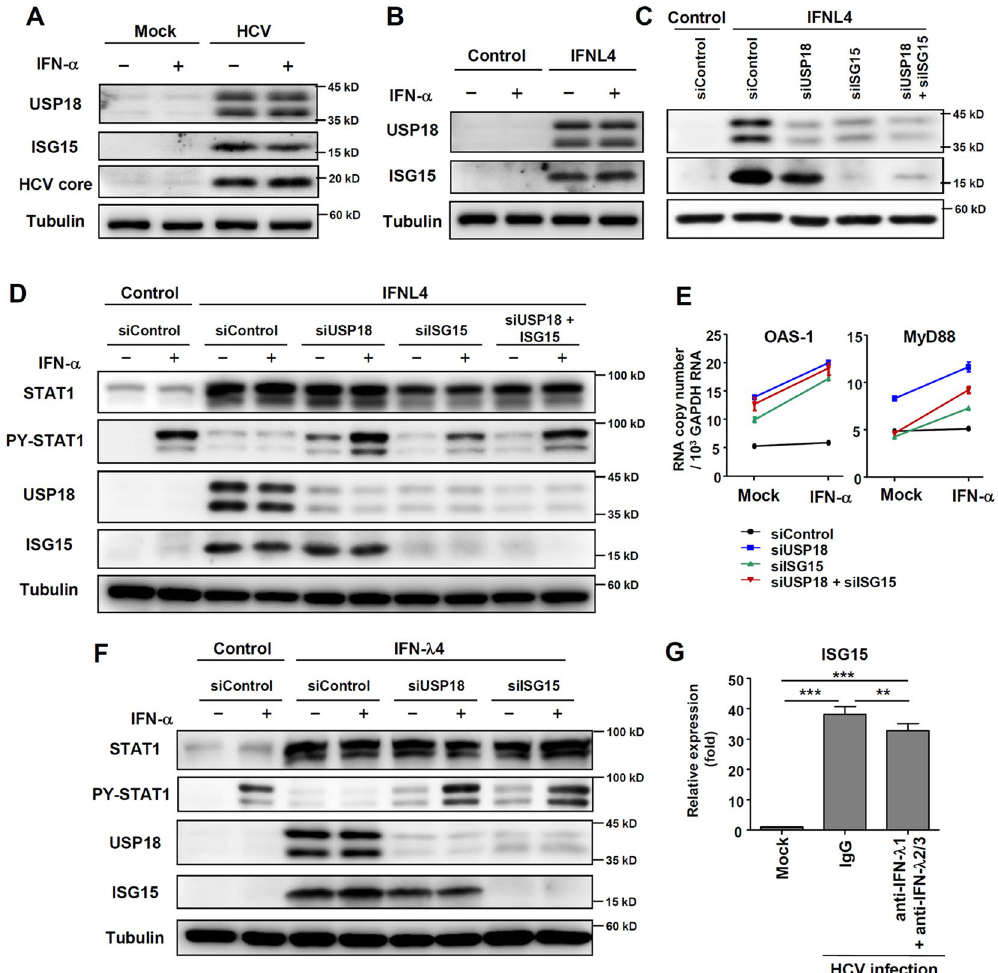
Figure 5. IFN- α unresponsiveness depends on ISG15 and USP18 in cells that overexpress IFN- λ 4 or treated with IFN- λ 4. ( A ) PHHs with the IFNL4 Δ G/ Δ G genotype were infected with JFH1 HCVcc at 5 MOI. After 72 hours, the cells were treated with 100 IU/ml of IFN- α for 30 minutes. ( B ) Huh-7 cells were transfected with control or IFN- λ 4-expressing plasmids. After 72 hours, the cells were treated with 100 IU IFN- α for 15 minutes. The cells were harvested, and protein expression was analysed by immunoblotting. ( C ) Huh-7 cells were transfected with control, USP18-, or ISG15-targeting siRNAs. After 24 hours, the cells were transfected with control or IFN- λ 4-expressing plasmids. After 48 hours, the cells were re-transfected with the respective siRNAs. The cells were harvested, and gene expression was analysed by immunoblotting 24 hours after the second siRNA transfection. ( D , E ) Huh-7 cells were transfected with control, USP18-, or ISG15-targeting siRNAs. After 24 hours, the cells were transfected with control or IFN- λ 4-expressing plasmids. After 48 hours, the cells were re-transfected with the respective siRNAs. After 48 hours, the cells were treated with 100 IU/ml of IFN- α for 15 minutes ( D ) or for 6 hours ( E ). Then the cells were harvested, and protein and gene expression were analysed by immunoblotting ( D ) or real-time qPCR ( E ). All the data are representative of two independent experiments. ( F ) Huh-7 cells were treated with or without 100 ng/mL recombinant IFN- λ 4. After 48 hours, the cells were transfected with control siRNAs, USP18-, or ISG15-targeting siRNAs. The USP18-, or ISG15-targeting siRNAs used in this experiment had different sequences from siRNAs used in the experiment for ( D ). After 48 hours, the cells were treated with 100 IU/ml of IFN- α for 15 minutes. Then the cells were harvested, and protein expression were analysed by immunoblotting. ( G ) PHHs with IFNL4 Δ G/ Δ G genotype were infected with JFH1 HCVcc at 15 MOI. After 6 hours, the cells were treated with 10 μ g/ml anti-IFN- λ 1 and 10 μ g/ml anti-IFN- λ 2/3 or IgG for 72 hours. The cells were harvested, and ISG15 gene expression was analysed by real-time qPCR. Data are presented as means ± S.E.M. ** P ≤ 0.01, *** P ≤ 0.001 (Student’s